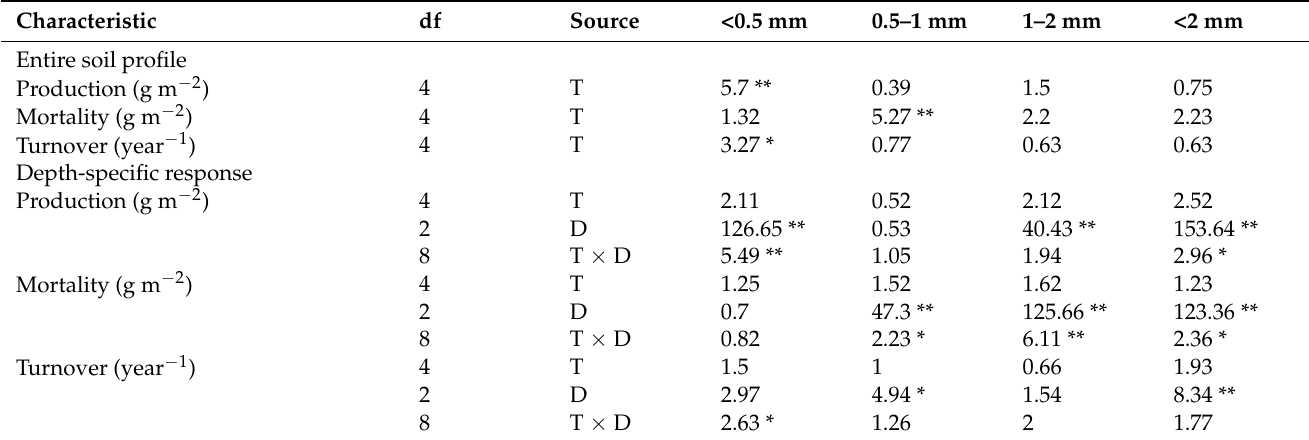
Table 5. The effects of the thinning intensity (T) on the annual production, mortality, and turnover rate of fine roots over the entire soil profile, and at specific depths